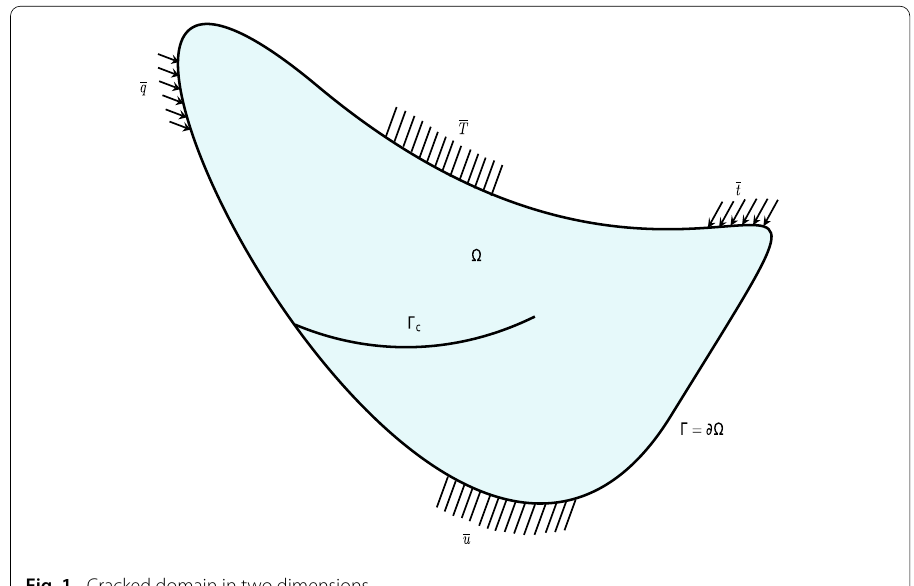
Fig. 1 Cracked domain in two